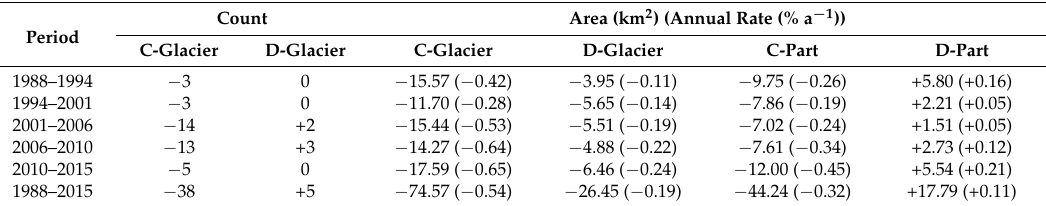
Table 3. Glacier changes between 1988 and 2015.